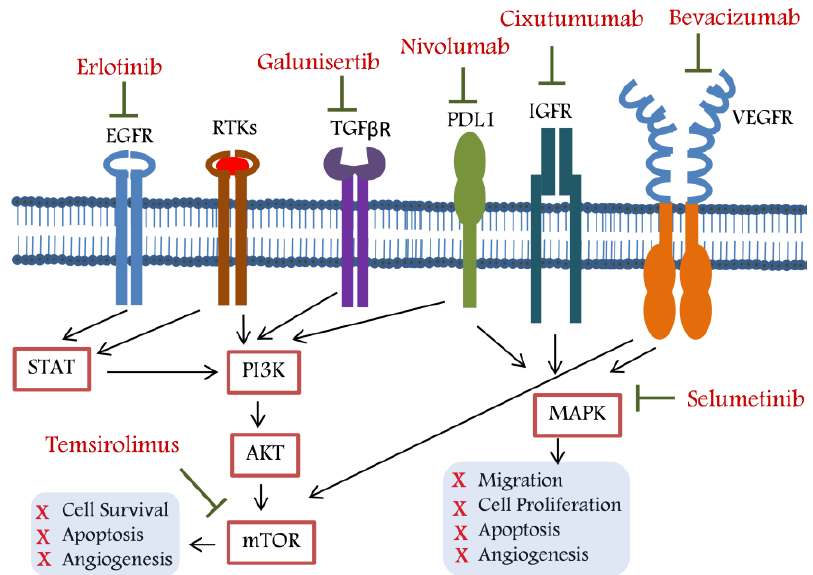
Figure 1. Therapeutic targets and respective drugs used for unresectable hepatocellular carcinoma. Erlotinib inhibits EGFR and thereby negatively regulates cancer hallmarks through modulating the STAT/PI3K/Akt/mTOR axis. Galunisertib inhibits TGF β R which in turn negatively regulates cancer hallmarks through the PI3K/Akt/mTOR axis. Nivolumab, cixtumumab, and bevacizumab inhibit PDL1, IGFR, and VEGFR, respectively, and thereby negatively regulate cancer hallmarks through MAPK. Temsirolimus and selumetinib directly inhibit mTOR and MAPK, respectively, and thereby negatively regulate cancer hallmarks in recurrent hepatocellular carcinoma.